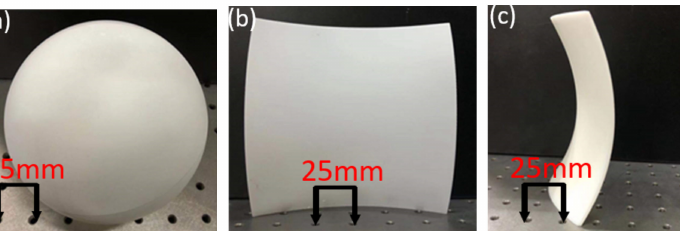
Figure 5. Two objects under test, including ( a ) a ball and ( b , c ) an object with a hyperbolic paraboloid surface. The front view and side view of the hyperbolic paraboloid object are shown.